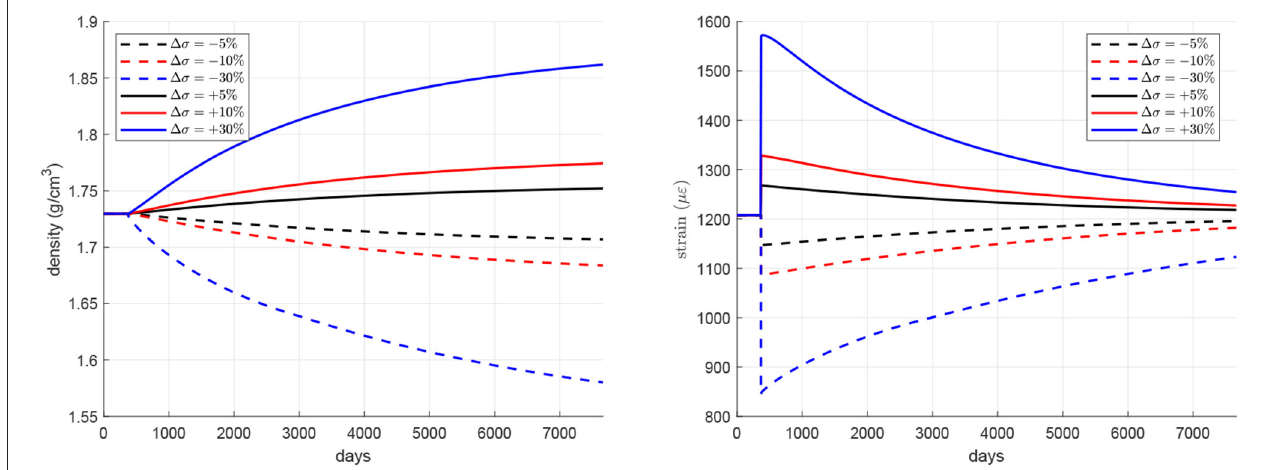
FIGURE 10 | Variation of density and strain under uniaxial loading simulating underuse and overuse